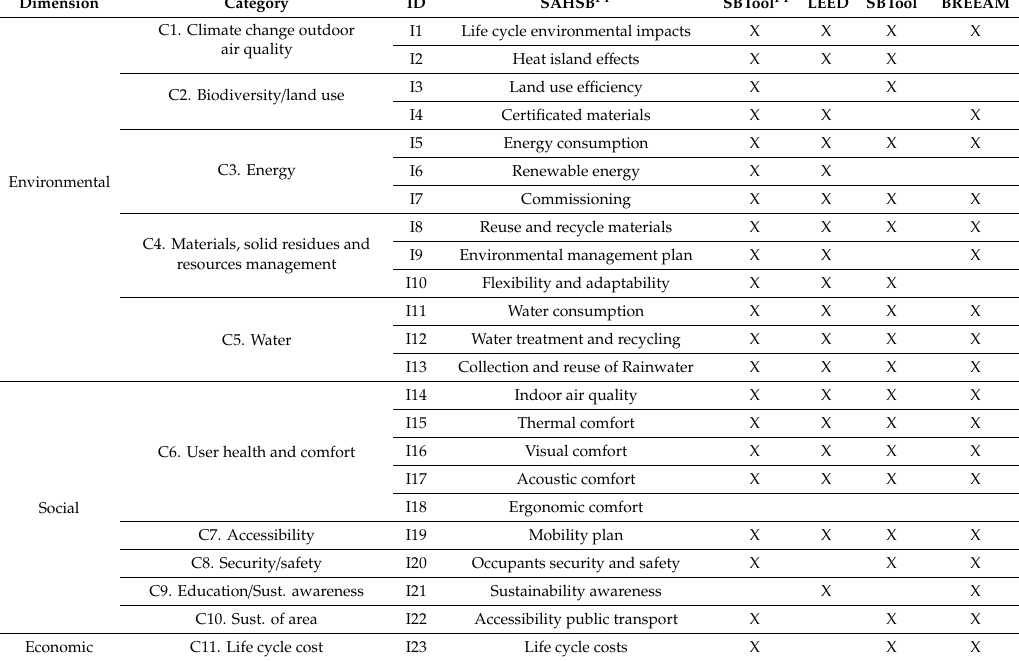
Table 2. List of indicators used by Sustainability Assessment of High School Buildings in